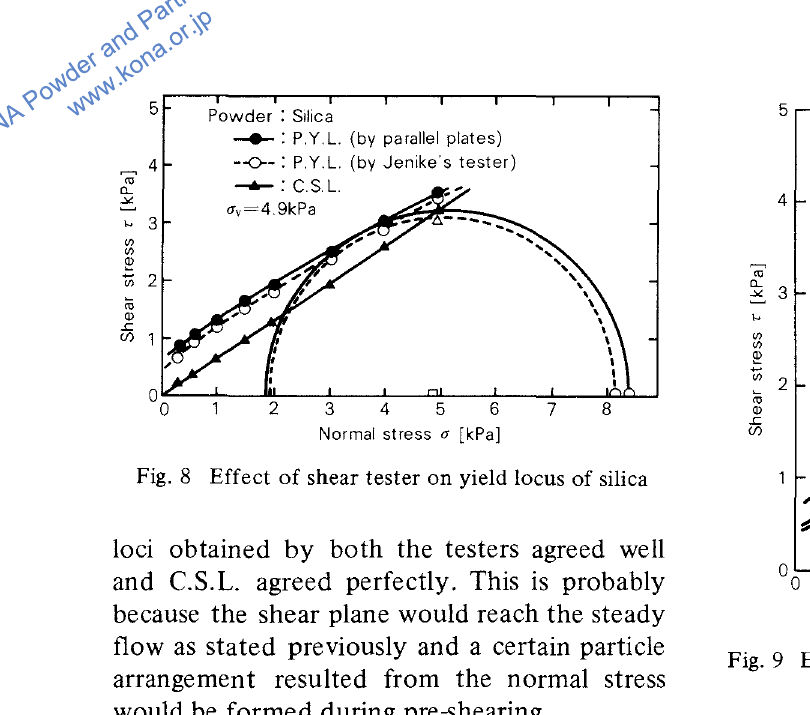
Fig. 9 Effect of consolidation method on Y.L. of silica